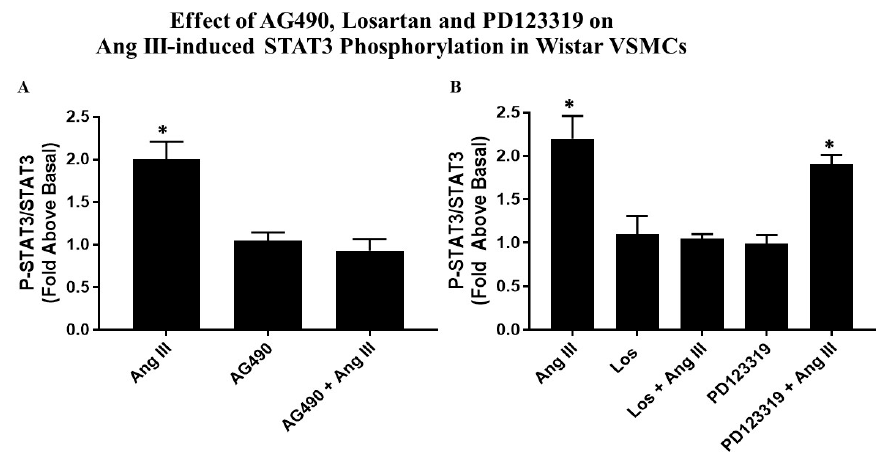
Figure 3. E ff ects of AG490, Losartan, PD123319 on Ang III-induced STAT3 Phosphorylation in Wistar VSMCs. Quiescent Wistar VSMCs were pretreated with either 50 µ M AG490 ( A ) or 10 µ M Losartan (Los) or 10 µ M PD123319 ( B ) for 15 min. Subsequently, the cells were treated with or without 100 nM Ang III for 10 min. Phosphorylated-STAT3 protein levels were measured by Western blot analysis using a specific antibody for the phosphorylated form of STAT3. Protein loading was visualized using the non-phosphorylated STAT3 antibody. The data were analyzed by densitometry and the amount of phosphorylation was calculated as the fold-increase above basal in the presence of vehicle. The vehicle for AG490 was DMSO; incubation with Ang III was also done in the presence of DMSO. Each value represents the mean ± SEM of preparations of VSMCs isolated from at five or more Wistar rats. * Denotes p < 0.05 as compared to basal levels of STAT3 expression in VSMCs isolated from Wistar rats.